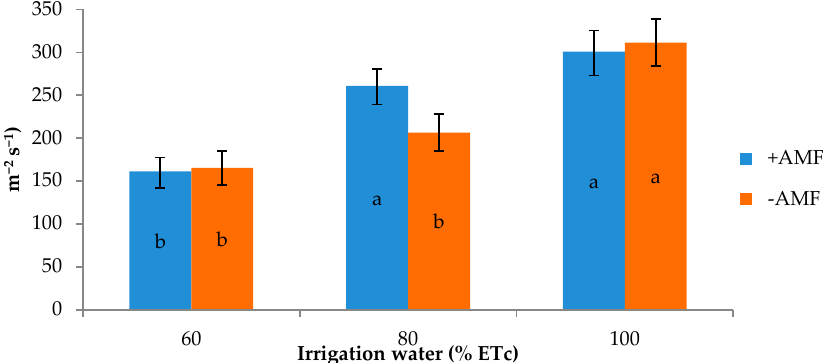
Figure 5. Effect of irrigation treatments and plant inoculation with arbuscular mycorrhizal fungi (AMF) on the stomatal conductance of melon leaves during two years of experiments (bars with different letters are significantly different at p < 0.05 according to the LSD test). − Yield characteristics of melon plants were significantly affected, mainly by deficit ir- rigation, but also due to a significant interaction between soil inoculation and irrigation management (Table 3). Table 3. Effect of irrigation treatments and plant inoculation with arbuscular mycorrhizal fungi (AMF) on yield components, irrigation water use efficiency (IWUE), and nitrogen applied efficiency (NAE) of melon plants during two years of experiments. Treatments